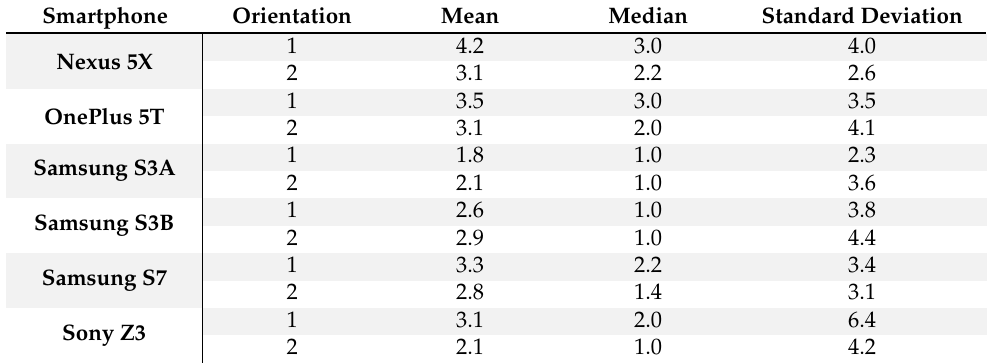
Figure 16. Two static positioning results on checkpoint 42 with the Samsung S3B with ( a ) worst and ( b ) overall best result. Table 8. Deviations in [m] from the ground truth in dependence of the smartphone for the static Table 7. Matching success rates (MSR) in the cells in the library (for the location of the cells see Figure 1).